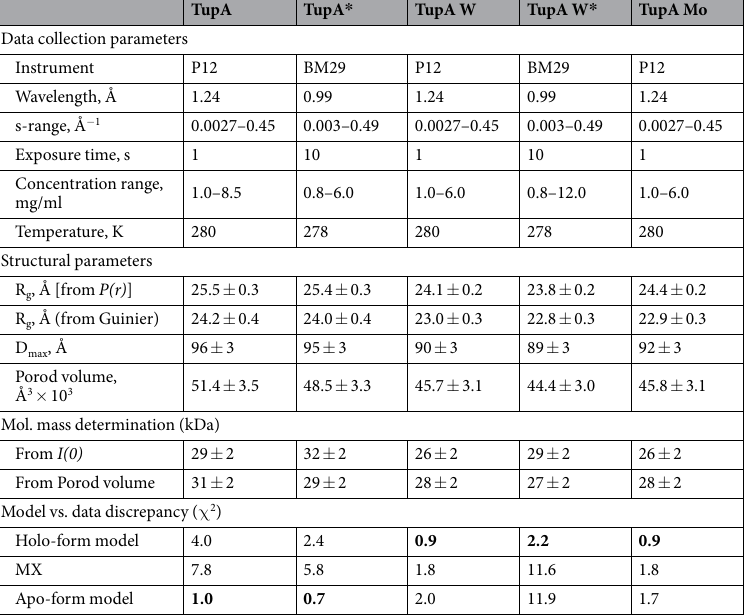
Table 1. Data collection and structural parameters obtained by SAXS. Molecular mass (M) was estimated from forward scattering I(0) and Porod volume respectively, the theoretical molecular mass predicted from sequence is 29.7 kDa. Radius of gyration, R g (Å) was calculated using the Guinier approximation and also the distance distribution function ( P ( r ) using GNOM), which also estimates maximum particle dimension ( D max ). χ 2 values correspond to discrepancies between models and experimental data, the lowest χ 2 value per dataset is highlighted. MX: crystal structure. * Data collected at BM29 beamline, ESRF, Grenoble, France. The rest of the datasets were collected at EMBL P12 beamline, DESY, Hamburg, Germany.